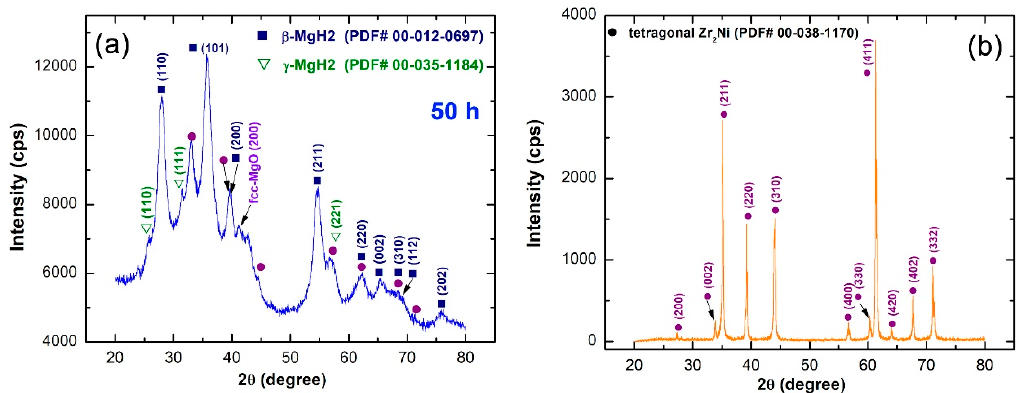
Figure 4. XRD patterns of ( a ) Mg powders milled for 50 h under 50 bar of H 2 , using Zr 2 Ni balls, ( b ) tetragonal ‐ Zr 2 Ni alloy used to manufacture ball milling media.